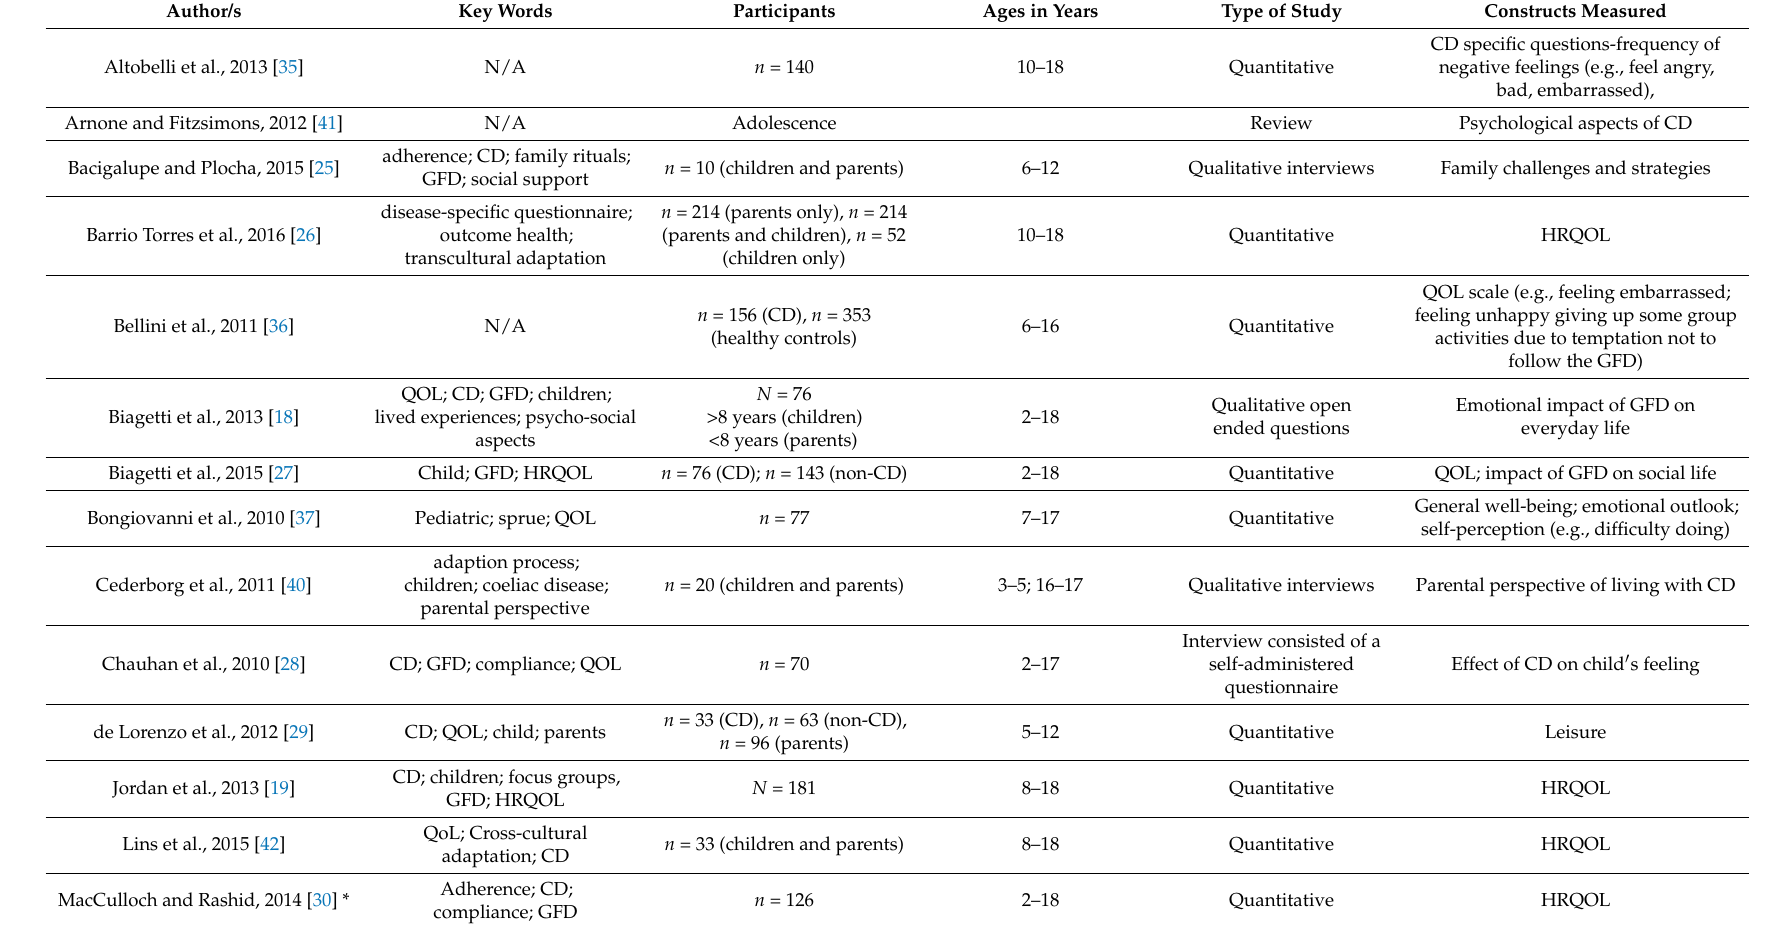
Table 1. Articles included in the scoping